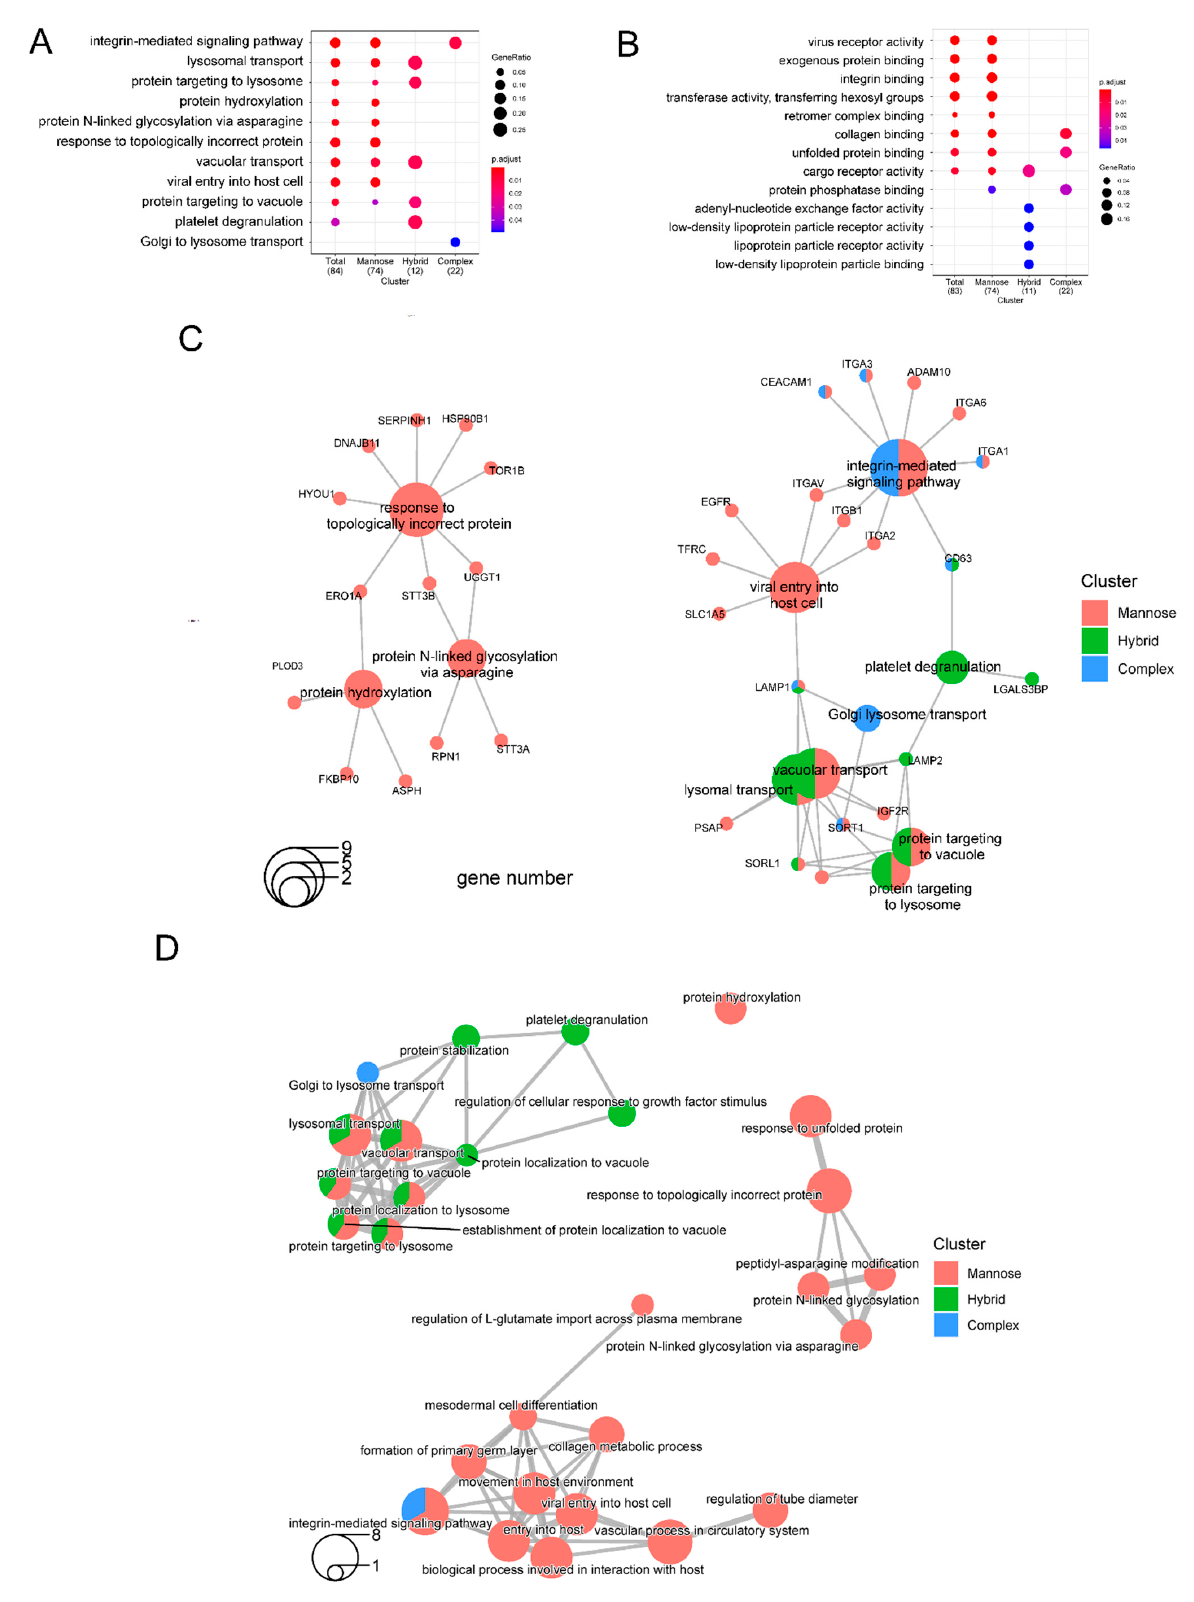
Figure 5. Functional clustering annotation of N -glycoproteins with down-regulation of the high- mannose-type induced by 2DG. ( A ) The enriched biological processes associated with the down- regulation of the high-mannose-type, including the integrin − mediated signaling pathway,